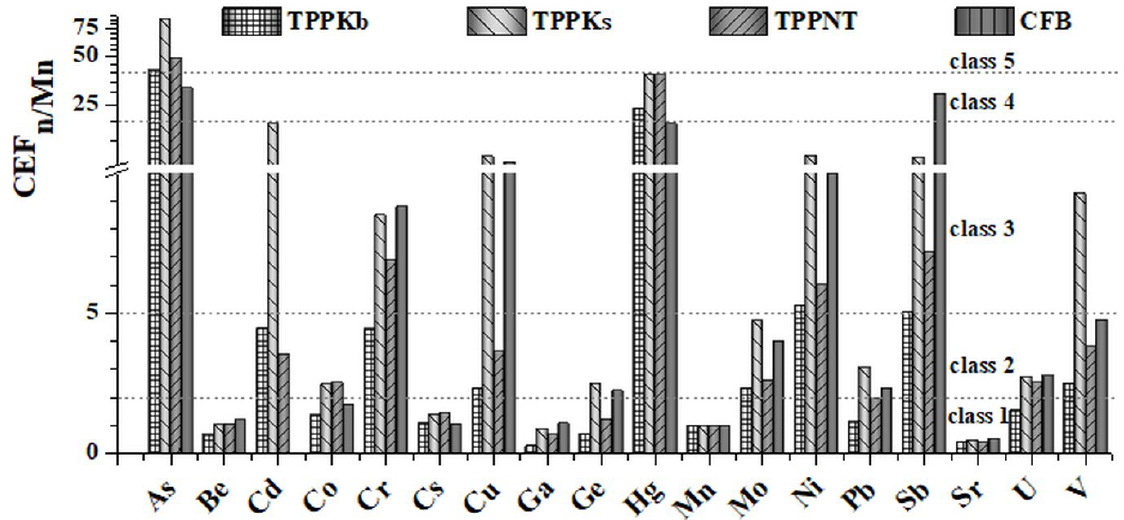
Table S 3 co mpares As, Cr, Hg, and Pb emission concentrations, ranging from